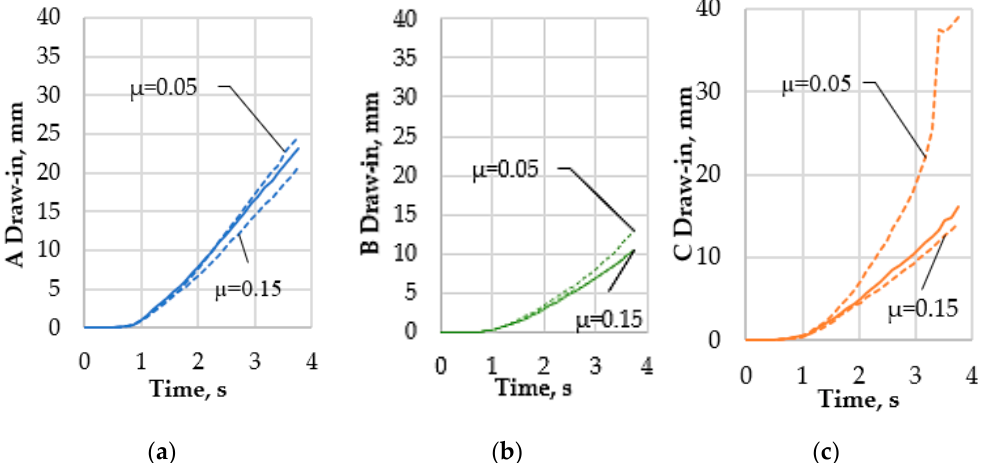
Figure 18. Draw-in over the time at point ( a ) A, ( b ) B, and ( c ) C for friction coefficient equal to 0.05, 0.11, and 0.15.